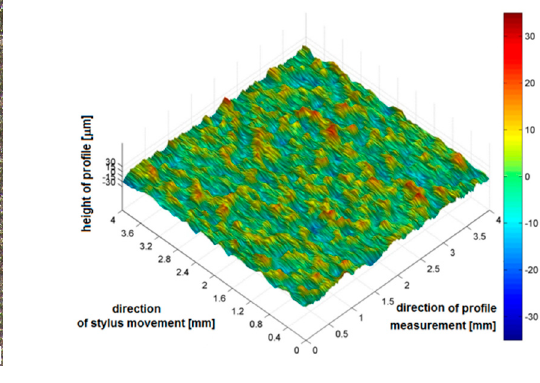
Table 6. Surface volume of evaluated surfaces (10 8 μ m 3 ).